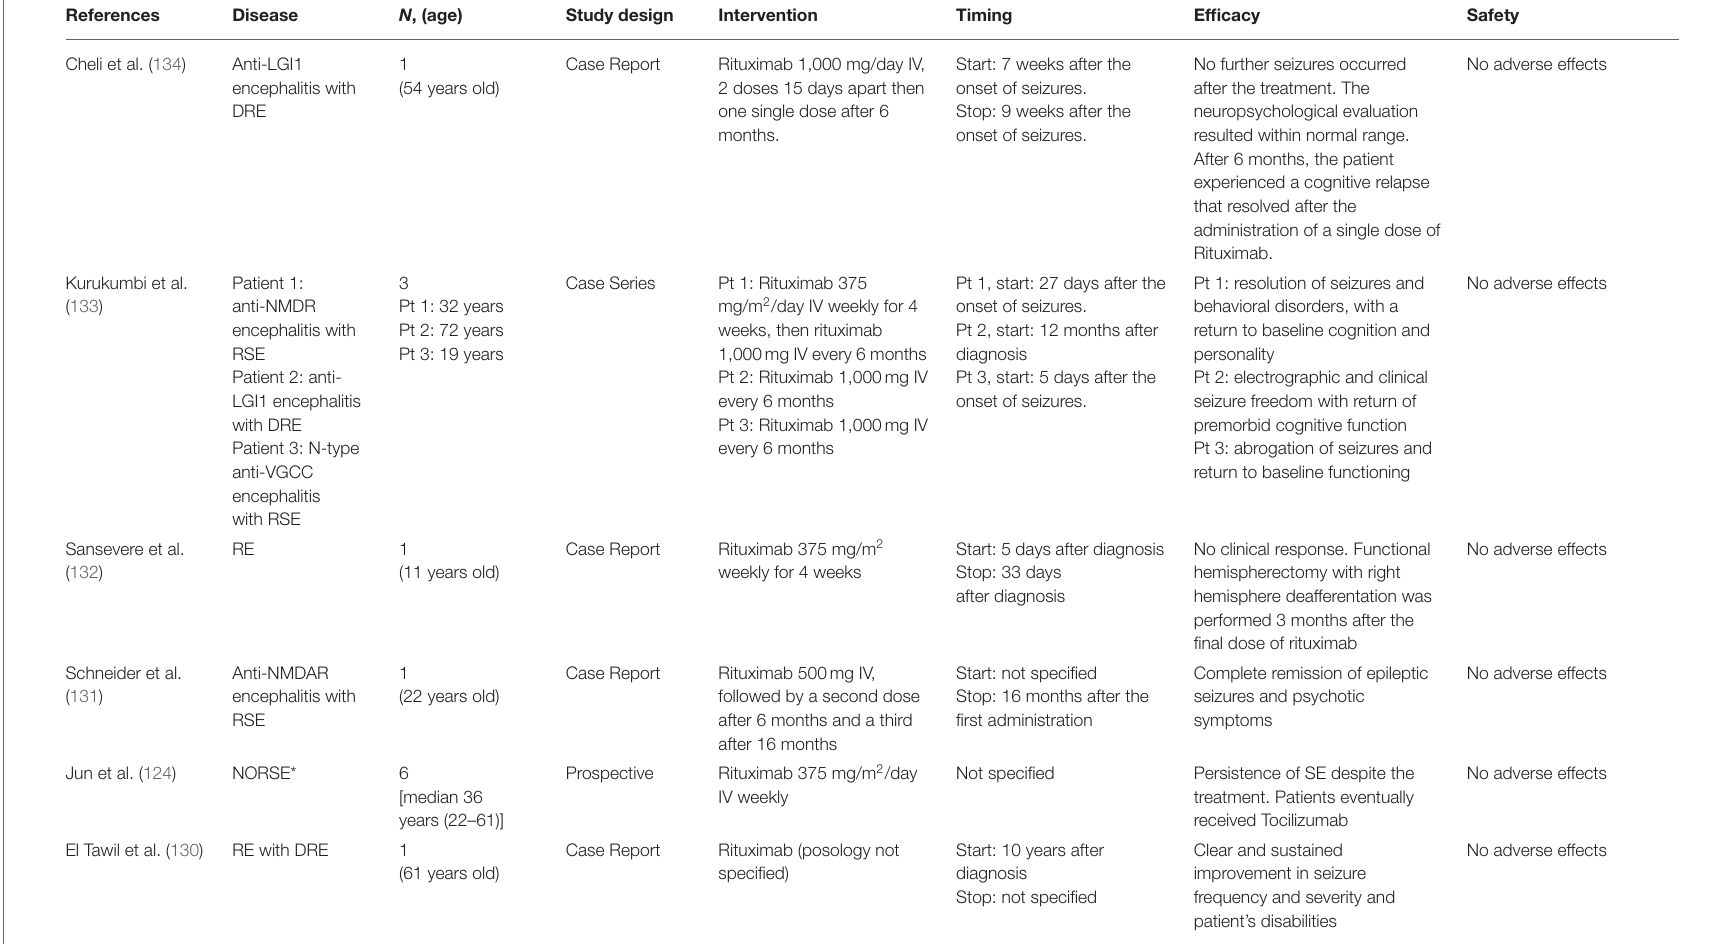
TABLE 5 | Systematic review of anti-CD20 agents in